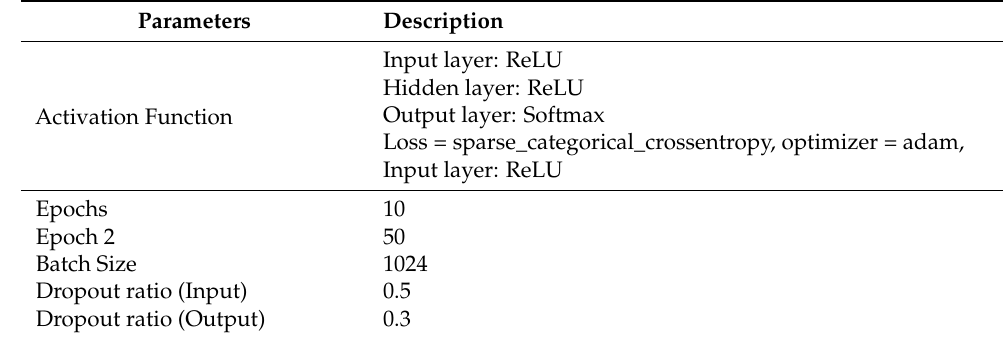
Table 5. Description of the convolutional neural network model.